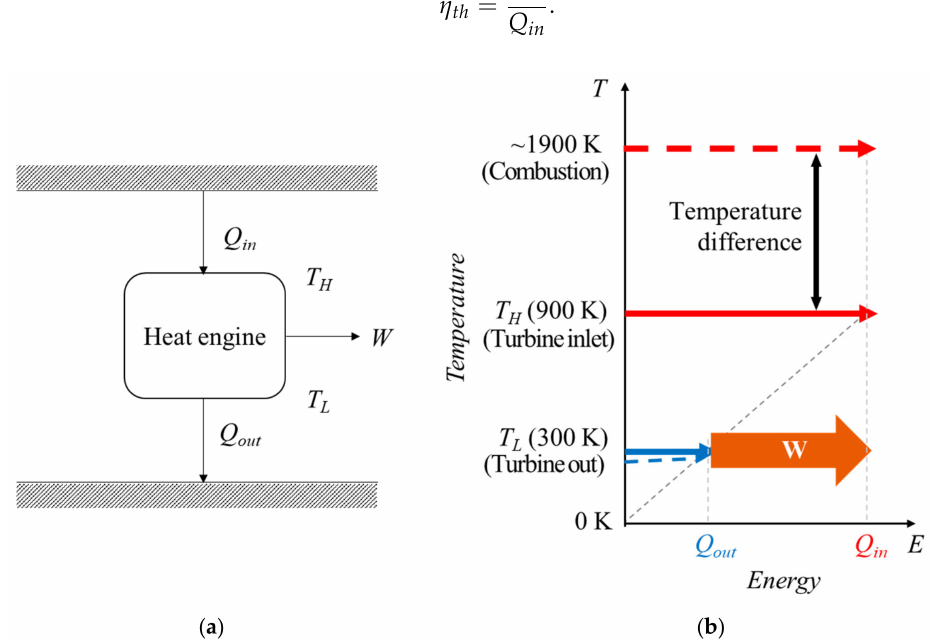
Figure 1. Concept of a heat engine driven by heat and the relationship between temperature and energy in conventional thermal power plants; ( a ) concept of a heat engine; ( b ) conceptual T – E diagram. The heat source is the combustion of the fuel. The work of the heat engine is the difference between Q in and Q out